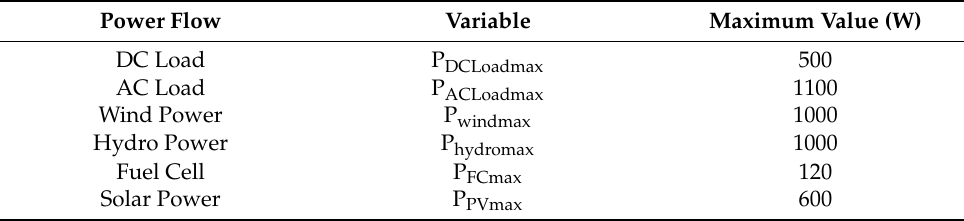
Table 3. Power flow design and the components maximum power value. Power Flow Variable Maximum Value (W) DC Load P DCLoadmax 500 AC Load P ACLoadmax 1100 Wind Power P windmax 1000 Hydro Power P hydromax 1000 Fuel Cell P FCmax 120 Solar Power P PVmax